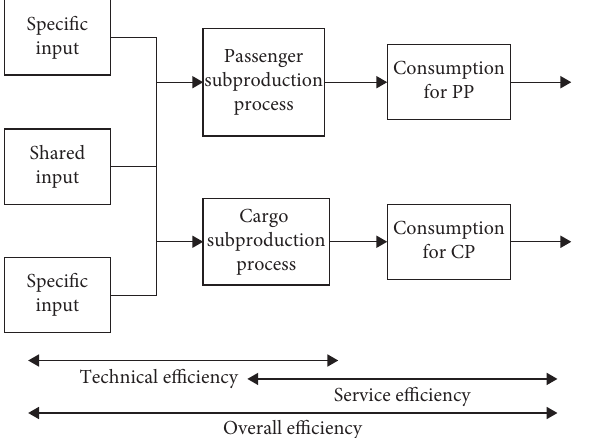
Figure 2: Three-stage series structure in [90].